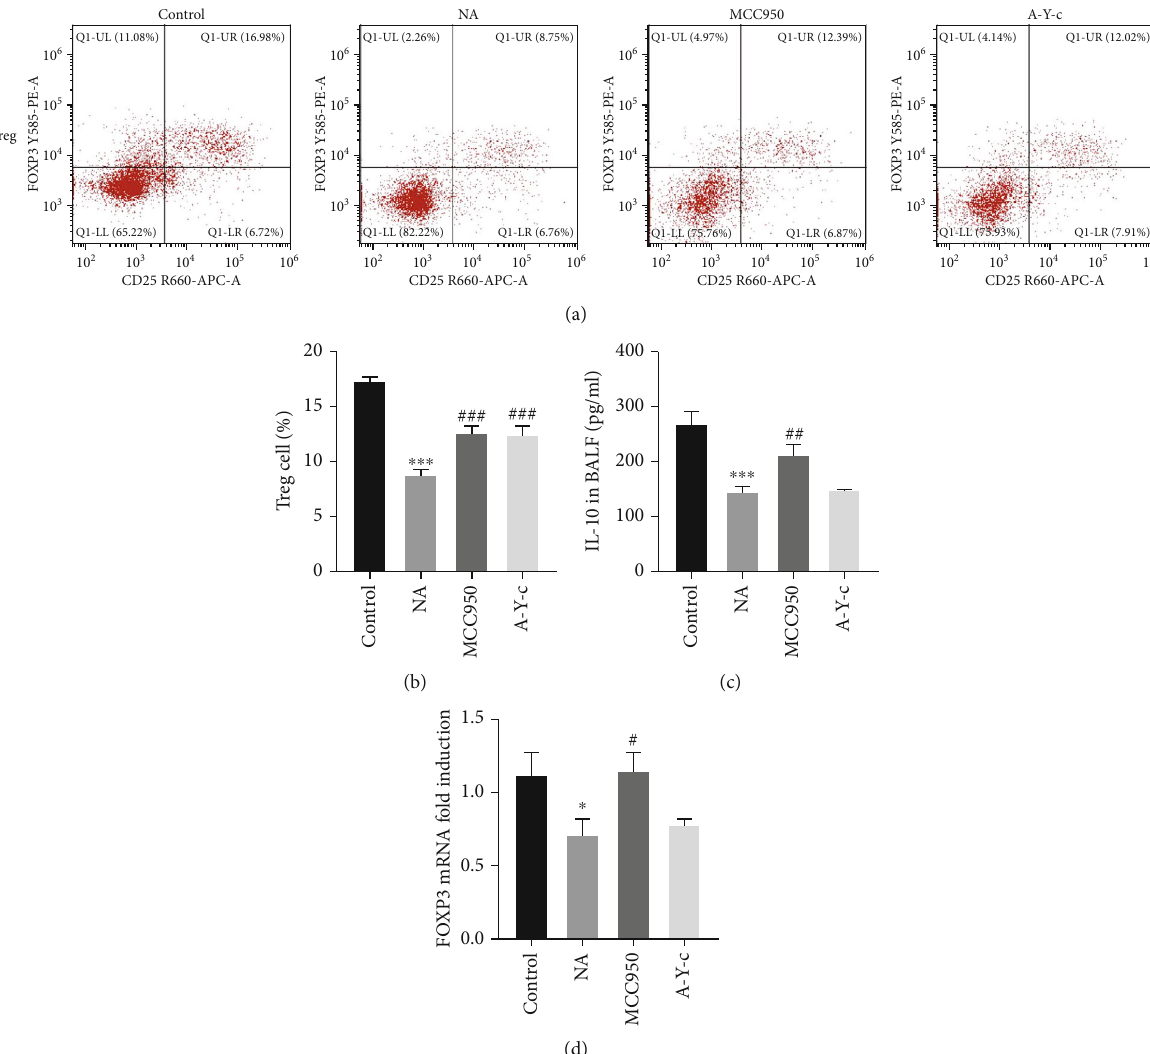
Figure 5: Inhibition of the NLRP3/caspase-1/IL-1 β pathway upregulated ovalbumin-induced Treg cell response. (a, b) Splenocytes were derived from mice and fi xed and permeabilized, and cells were incubated with extracellular and intracellular antibodies. Stained cells were run on the CytoFLEX Flow Analyzer and analyzed with CytExpert software. (c) The concentration of IL-10 in BALF was quanti fi ed by ELISA. (d) mRNA expression of Foxp3 in lung homogenates was detected by real-time PCR. Data are expressed as mean ± SEM . n = 6 . Compared to the control group, ∗ p < 0 : 05 , ∗∗ p < 0 : 01 , and ∗∗∗ p < 0 : 001 ; compared to the neutrophilic asthma group, # p < 0 : 05 , ## p < 0 : 01 , and ### p < 0 : 001 . NLRP3: nucleotide-binding oligomerization domain-like receptor family pyrin domain containing 3; BALF; bronchoalveolar lavage fl uid; ELISA: enzyme-linked immunosorbent assay; Foxp3: fork head box p3; PCR: polymerase chain